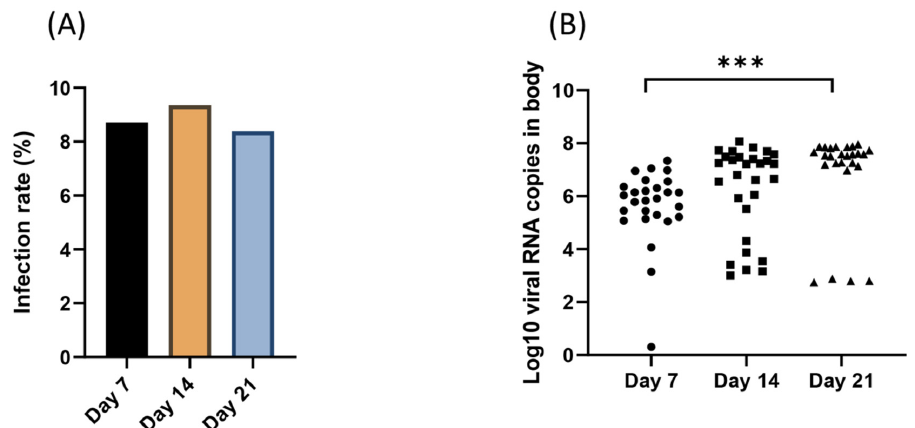
Figure 1. Infection rate ( A ) and viral RNA copies measured in bodies ( B ) at 7, 14, and 21 days after exposure of Culex pipiens s.l. to West Nile virus at a titer of 10 7.3 pfu / mL. Viral RNA particles were detected within bodies by RT-qPCR. *** p ≤ 0.001.